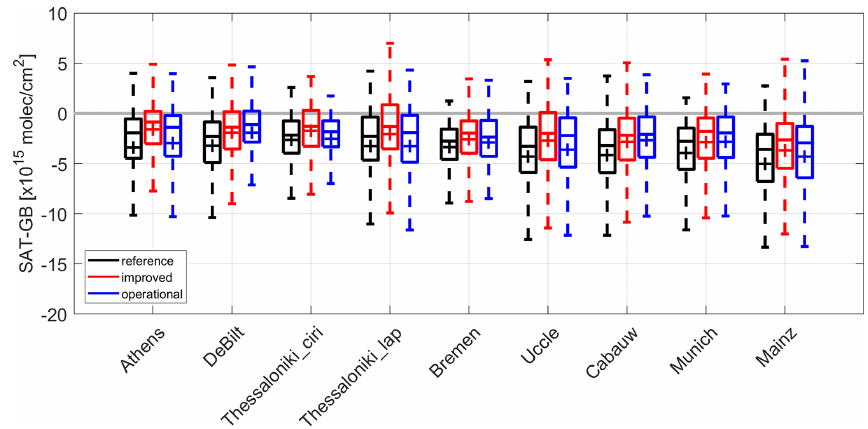
Figure 24. Box-and-whisker plot of the daily biases and spread of the differences between the TROPOMI (SAT) and MAX-DOAS (GB) data. Results for the reference algorithm, the improved algorithm, and the operational product are compared. Stations are ordered by increasing mean difference. The mean differences are represented by crosses. The median differences are represented by vertical solid lines inside the boxes, which mark the 25% and 75% quantiles. The whiskers cover the 9%–91% range of the differences. Table 5. The Pearson correlation coefficient R , as well as the slope S and intercept I (in 1 × 10 15 molec./cm 2 ) obtained with the robust Theil– Sen estimator for the monthly TROPOMI tropospheric NO 2 product compared to MAX-DOAS data. Stations are ordered by increasing mean difference. Values for the DLR improved algorithm (DLRimp) are given, and the values for the DLR reference algorithm (DLRref) and the KNMI operational product (KNMIop) are reported for